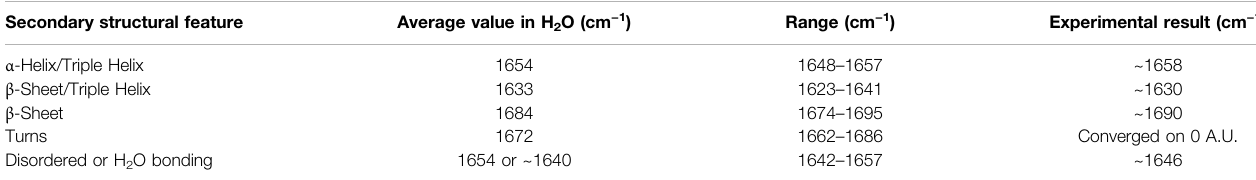
TABLE 2 | Average peak values for spectra of hydrated collagen fi lms after background electrolyte and water vapor spectral subtraction, determined experimentally and using corresponding values reported in the literature [21, 22]. Secondary structural feature